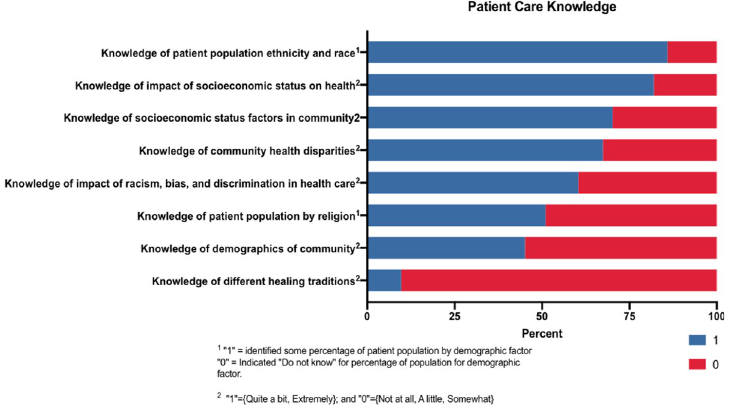
Fig 1. Patient care knowledge results. 1 “1” = Identified some percentage of patient population by demographic factor “0” = Indicated “Do not know” for percentage of population for demographic factor. 2 “1” = {Quite a bit, Extremely}; and “0” = {Not at all, A little, Somewhat}.